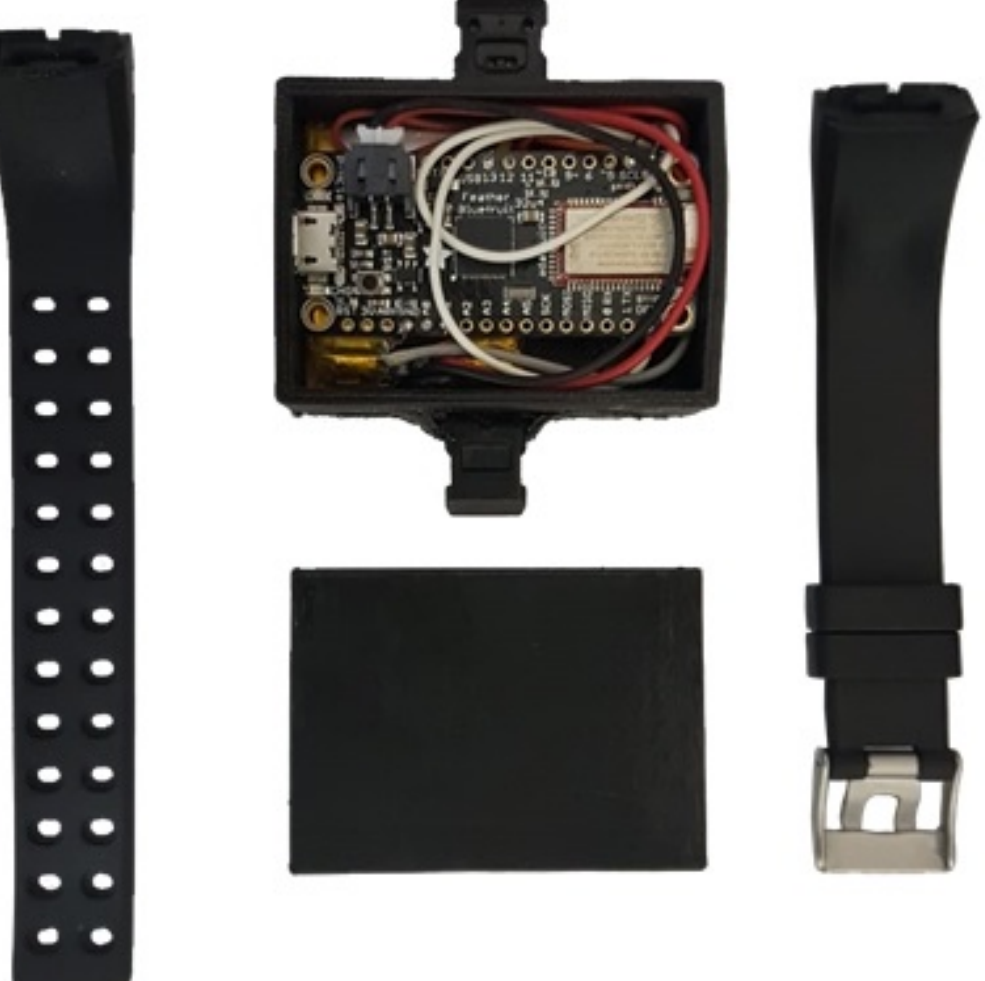
Figure 3. Prototype of the self-designed photoplethysmography sensor